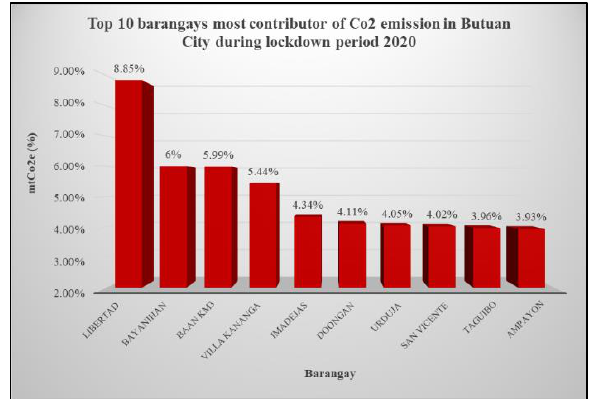
Figure 8. Top 10 most contributor of Carbon dioxide emission in Butuan City during COVID -19 Lockdown